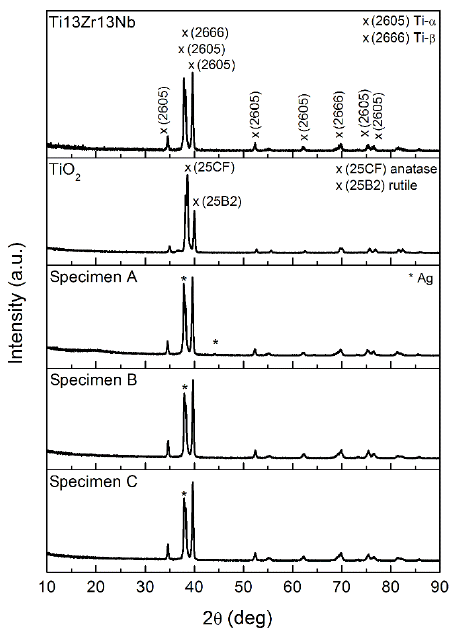
Figure 7. X-ray diffractogram of the Ti13Zr13Nb substrate, and the substrate with the TiO 2 nanotube layer, Specimens A, B, and C. The peak intensities are normalized.